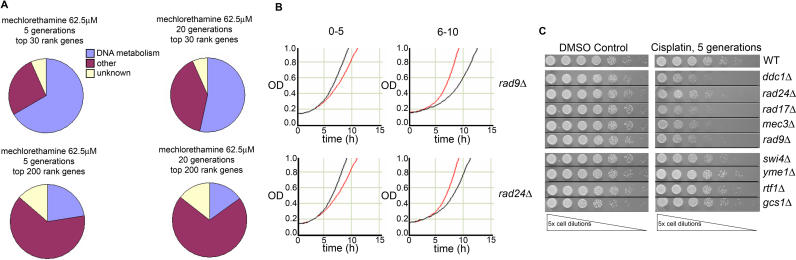
The Effect of Exposure Duration on the Genetic Requirements for Resistance to DNA-Damaging Agents(A) Pie charts showing relative percentage of sensitive genes categorized into either “DNA metabolism”, “unknown”, or “other”. All of the Gene Ontology [63] slim annotations (ftp://ftp.yeastgenome.org/yeast/data_download/literature_curation/go_slim_mapping.tab. Accessed February 17, 2005) are combined into “other” except for those classified in the unknown or DNA-metabolism category. The relative distributions of the mechlorethamine experiments are shown as a function of both time and gene rank.(B) BY4743 (wild-type) and the DNA-damage-checkpoint mutants, rad9Δ and rad24Δ, were grown in the presence of 500 μM cisplatin over the course of ten population doublings. Yeast cultures were maintained in an exponential phase of growth by robotic dilution of cultures after five doublings into fresh media containing cisplatin. The growth of each deletion strain (black curve) is compared to that of BY4743 (red curve) between 0–5 (left) and 6–10 (right) population doublings. The rad9Δ and rad24Δ deletion strains exhibit accelerated grow rates in the first five generations, but by ten generations begin to demonstrate slow growth as compared to wild-type.(C) Viability assay of strains treated with cisplatin or DMSO for five generations. Indicated strains were removed from cultures after they reached an OD600 of 2.0, and were diluted as shown. Strains were chosen based on the criteria that they did not show a growth defect at five generations but did show a growth defect at 20 generations. Dilutions were pinned onto YPD plates in a 5-fold concentration series. The wild-type parental diploid strain is compared to several diploid deletion strains that exhibited a decrease in viability: ddc1Δ, rad24Δ, rad17Δ, mec3Δ, and rad9Δ. In contrast, several of these strains showed little or no decrease in viability at five generations of growth: swi4Δ, yme1Δ, rtf1Δ, and gcs1Δ. This figure underscores the point that, despite the lack of an apparent growth defect in liquid culture, several deletion strains lose viability relatively rapidly when exposed to cisplatin.